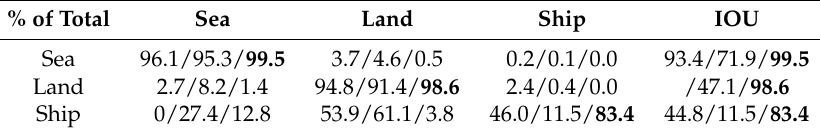
Table 6. Accuracy of segmentation of different methods. Confusion matrix with percentages row-normalized and IOU of each class.